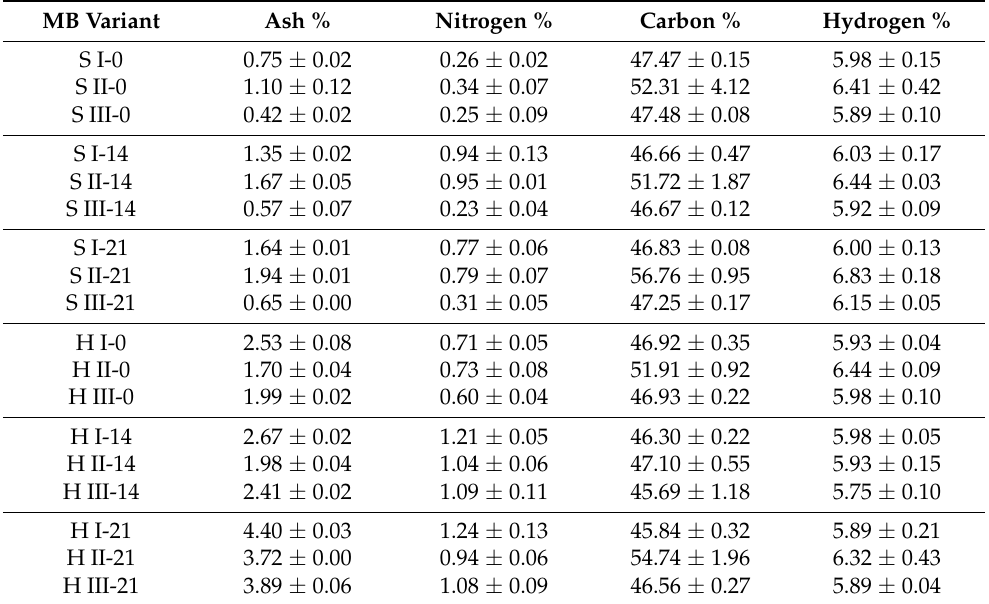
Table 4. Ash content and elemental composition N, C, H at three mycelium biocomposites (MB) development stages: start point (0 days), 14 days, and 21 days (final sample). S = sawdust; H = hemp; I, II, III =